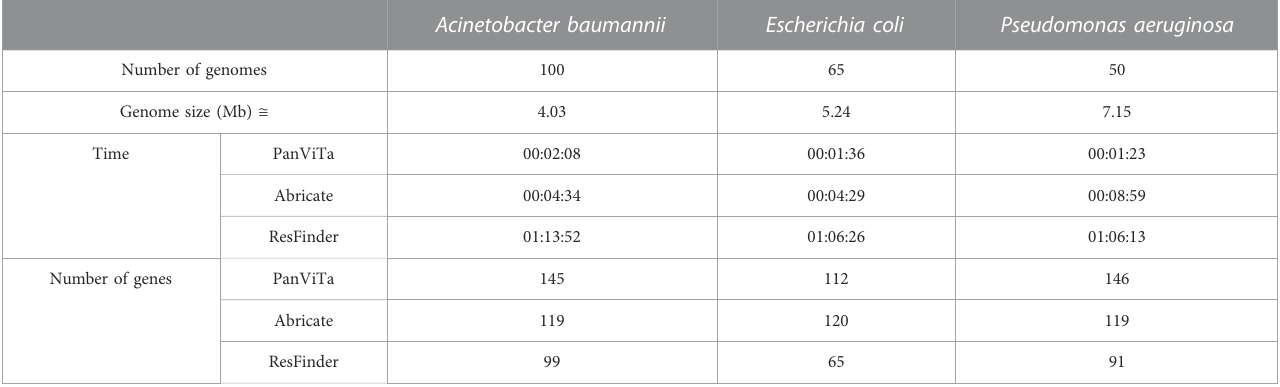
TABLE 1 Results obtained based on the comparison of the three tools